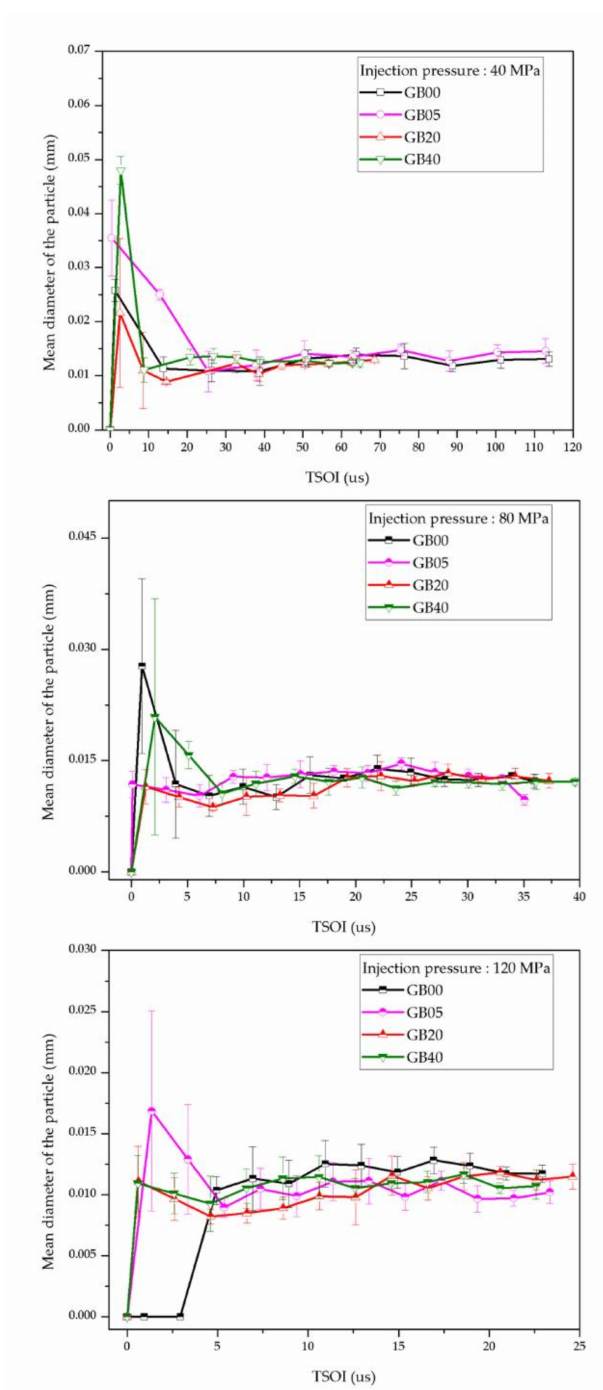
Figure 10. Mean diameters of the particles observed around the spray development of GB fuels according to the injection pressure. Top row: 40MPa, Middle row: 80 MPa, Bottom row: 120 MPa (GB00: gasoline 100% and biodiesel 0%, GB05: gasoline 95% and biodiesel 5%, GB20: gasoline 80% and biodiesel 20%, GB40: gasoline 60% and biodiesel